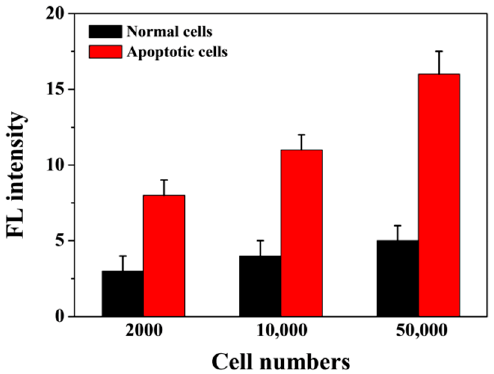
Figure 5. Results for the detection of Cas3 in the normal and apoptotic cells.